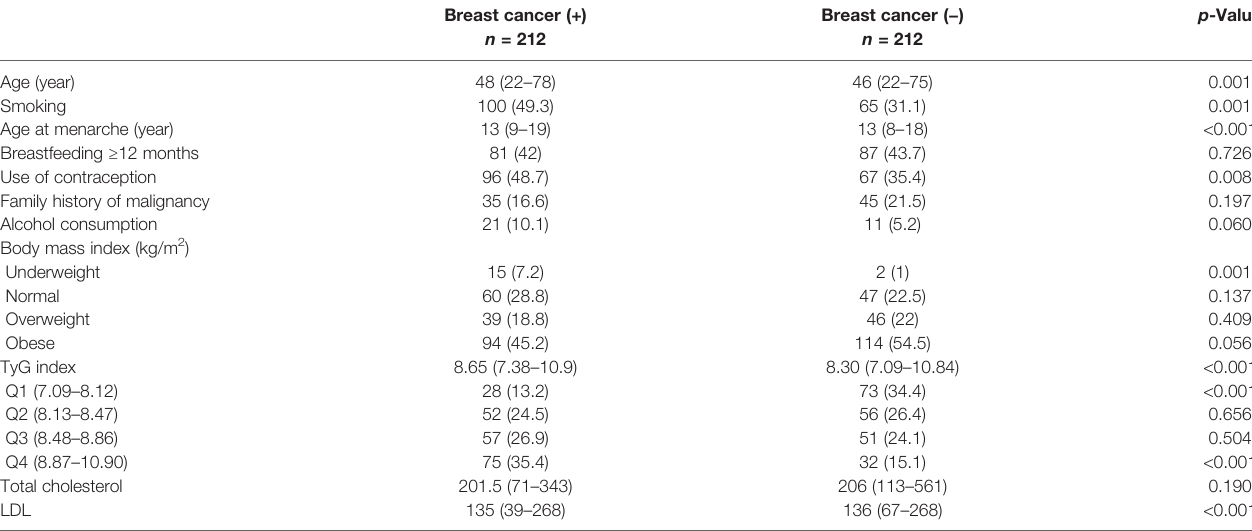
TABLE 1 | Baseline characteristics of study